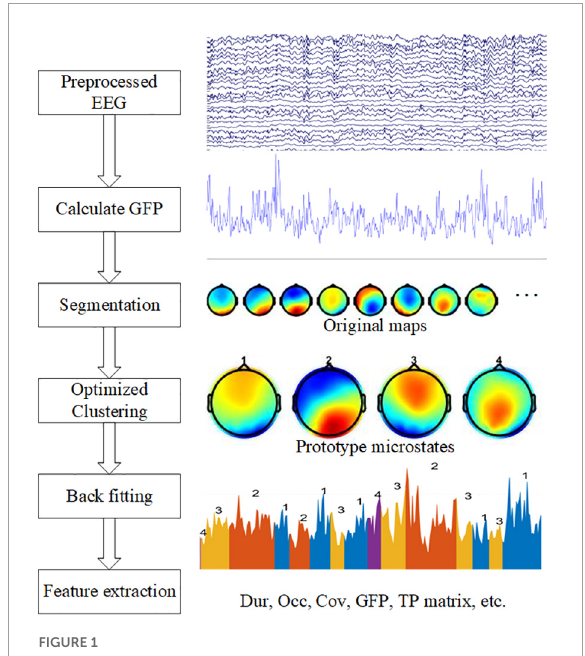
FIGURE1 Graphical representation of the analysis method in the study. The left side shows five steps: calculate GFP, EEG segmentation, optimized clustering, back fitting, and feature extraction. On the right side are examples of each step.